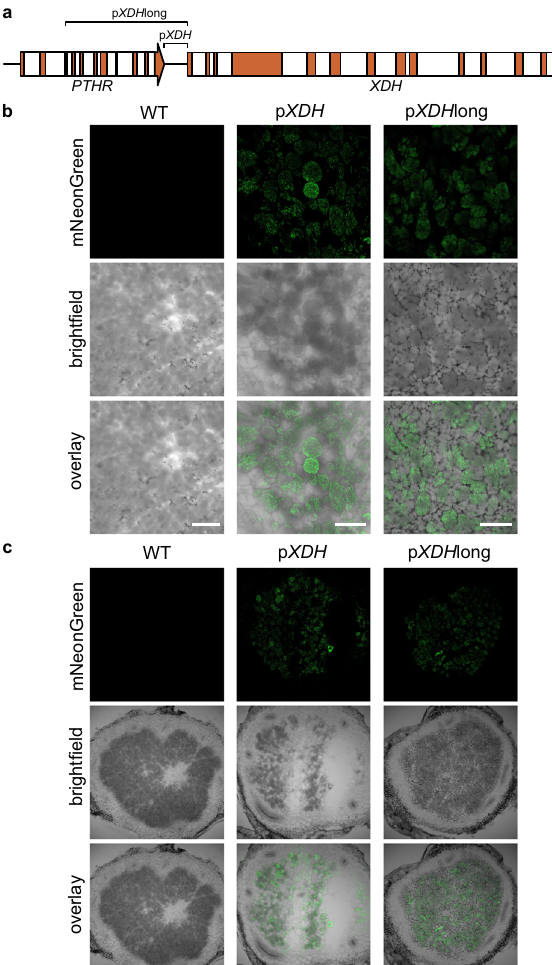
Fig. 6 | Cell-type speci fi c activity of the XDH promoter in the common bean nodule. Confocal fl uorescencemicroscopyimagesofcrosssectionsfromwildtype (WT) nodules or nodules expressing the coding sequence of peroxisome targeted mNeonGreen under the control of the 735bp XDH promoter (p XDH ) or a 3kb version of the promoter(p XDH long),that includes the 3 ’ -partofagene encoding a phosphate acyltransferase (PTHR; locus Phvul.L009443). a Schematic overview of genestructuresandpromoterregion.Exonandintronstructureswithinthecoding region are displayed in orange and white, respectively. b Focus on the central infectedregion, consisting of infected (darkgrey)and uninfected (light grey)cells. Scale bar, 100 µ m. c Whole nodules. Scale bar, 225 µ m. From top to bottom, mNeonGreenchannel,bright fi eldchannelandoverlayofbothchannels.Imagesare representative of at least three nodules from independent transgenic roots. The experiment was performed once with the 3kb promoter and three times with the 735bp promoter, with similar results (Fig. 5 and Supplementary Fig.